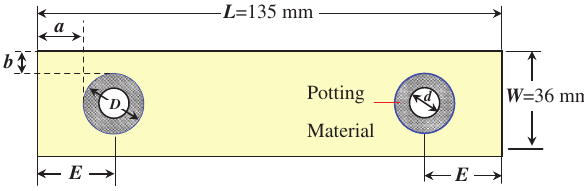
Figure 3 Dimensions of the test samples.